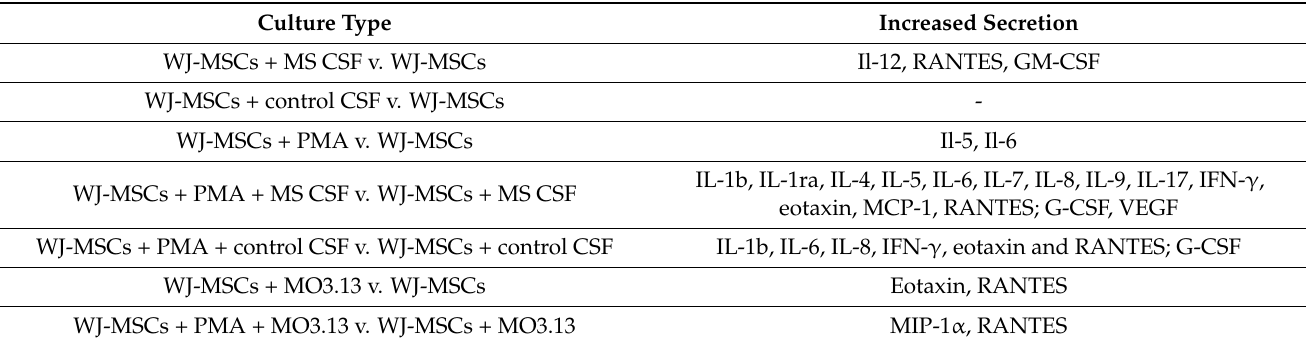
Figure 2. The effect of the WJ ‐ MSCs culture conditioned with MS CSF and the control CSF con ‐ ducted with the addition of phorbol 12 ‐ myristate 13 acetate (PMA). The average concentration of secreted cytokines, chemokines ( A ) and growth factors ( B ) given in pg/mL as means ± SD from 4 samples for WJ ‐ MSCs, 11 for WJ ‐ MSCs + MS CSFs and 7 for WJ ‐ MSCs + control CSFs, from 2 exper ‐ iments for WJ ‐ MSCs with PMA, 3 for WJ ‐ MSCs + MS CSF with PMA and 2 for WJ ‐ MSCs + control CSF with PMA. Statistically significant decreases in secretion ( p < 0.05) were observed for Il ‐ 4, Il ‐ 6, Il ‐ 8, eotaxin and VEGF for the WJ ‐ MSCs culture compared to the WJ ‐ MSCs with MS CSF; Il ‐ 1b, Il ‐ 4, Il ‐ 6, Il ‐ 8, Il ‐ 9, Il ‐ 15, eotaxin, IFN γ , MCP ‐ 1, G ‐ CSF and VEGF for the WJ ‐ MSCs culture compared to WJ ‐ MSCs with the control CSF. Table 1. Changes in factors secreted by WJ ‐ MSCs growing in CSF and oligendrocytic MO3.13 cell line microenvironment. Most of the secreted cytokines, chemokines and growth factors concentra ‐ tions were reduced by conditioning with CSF or MO3.13 cell line co ‐ culture; increased factors are listed in the